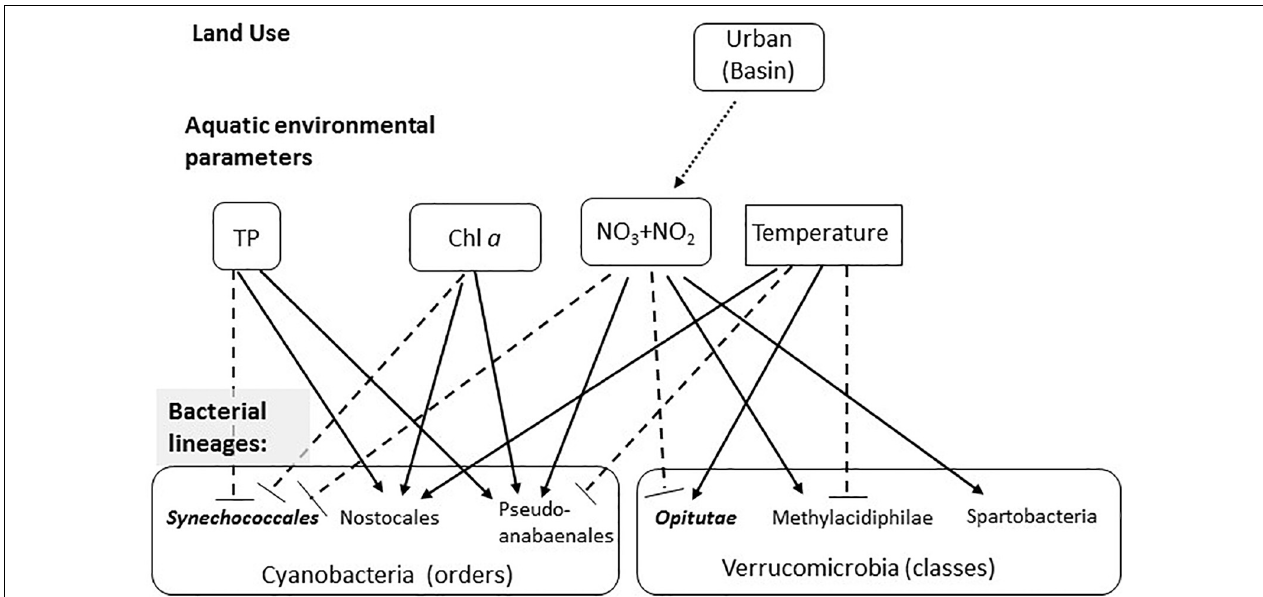
FIGURE 6 | Conceptual model summarizing the observed effects of land use on water chemistry, and of water chemistry on selected microbial lineages. The first layer represents the effect of land use on aquatic environmental parameters (based on the GLMs), with the arrow showing the significant correlation between urban land and NO 2 + NO 3 . The seconds layer shows the effect of the four environmental parameters shown to significantly affect the microbiome structure (based on the CCA analysis) on selected microbial linages within the Cyanobacteria and Verrucomicrobia. Solid arrows show significant positive correlations (based on the permutation analysis), dotted blunt-ended lines show negative correlations. Lineages that are more clustered than randomly expected are in bold and